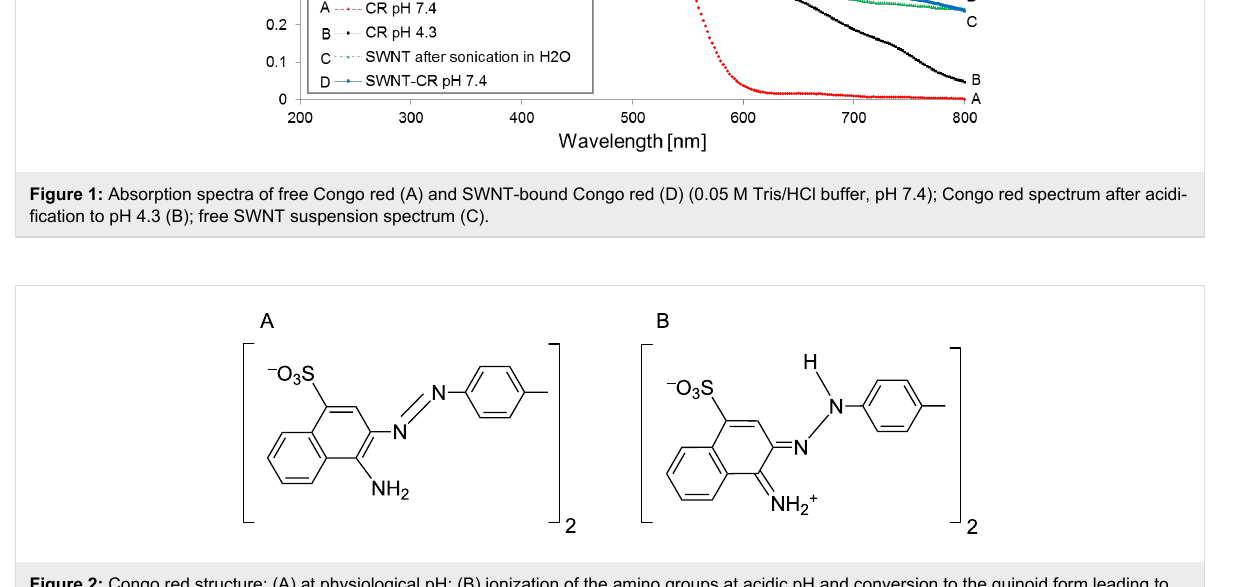
Figure 2: Congo red structure: (A) at physiological pH; (B) ionization of the amino groups at acidic pH and conversion to the quinoid form leading to the change of